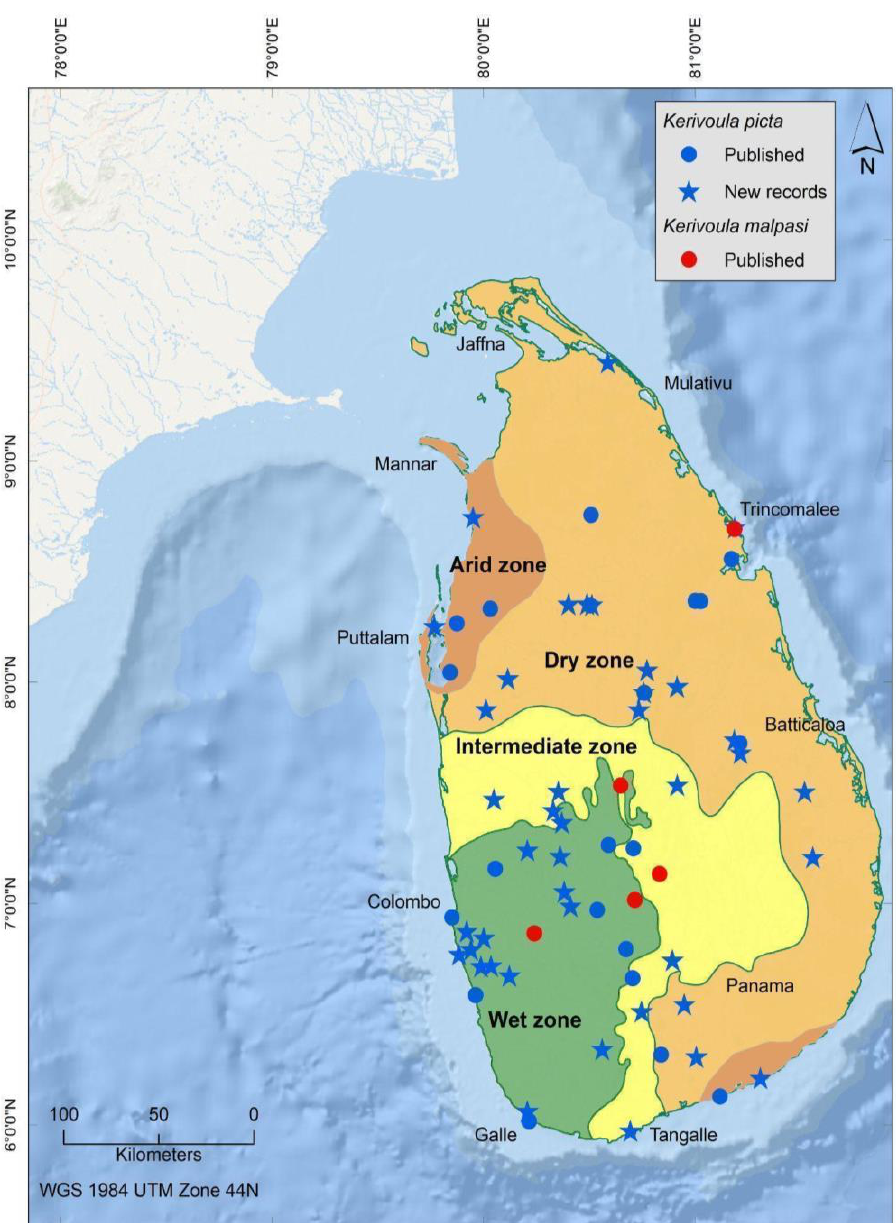
Figure 2. Updated distribution map of K. picta and K. malpasi in Sri Lanka. Published records were extracted from the literature [3,10,36,40 – 48]. New records are from unpublished data from personal observations of the authors and personnel communications with expert field biologists.